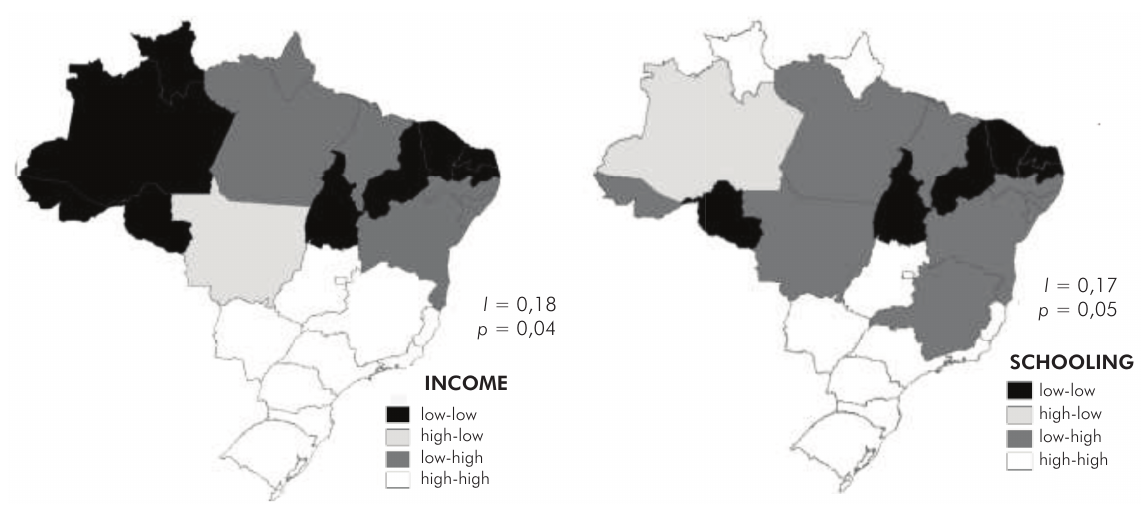
Figure 2. Box map of spatial distribution of Brazilian socioeconomic conditions showing household per capita income and level of education in 2009.